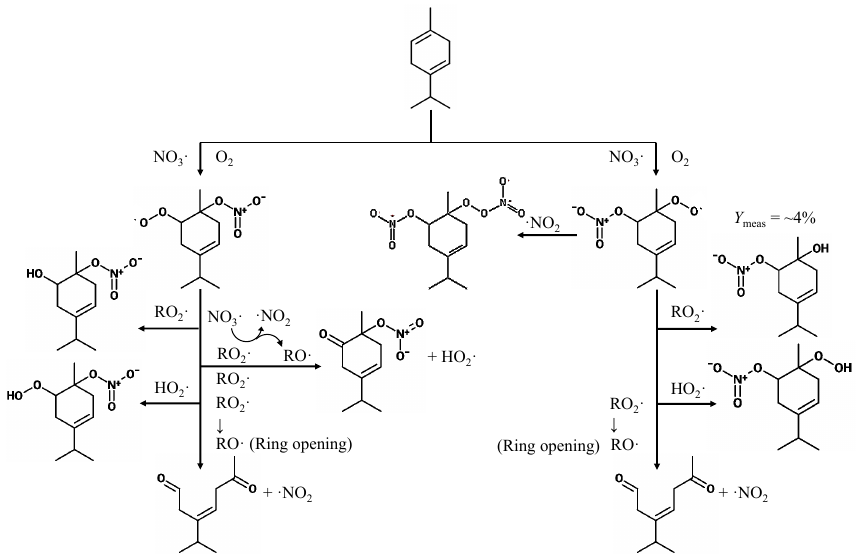
Figure 5. Proposed initial reaction pathways for the NO 3 oxidation of γ -terpinene. For simplicity, only the first-generation oxidation products are shown.